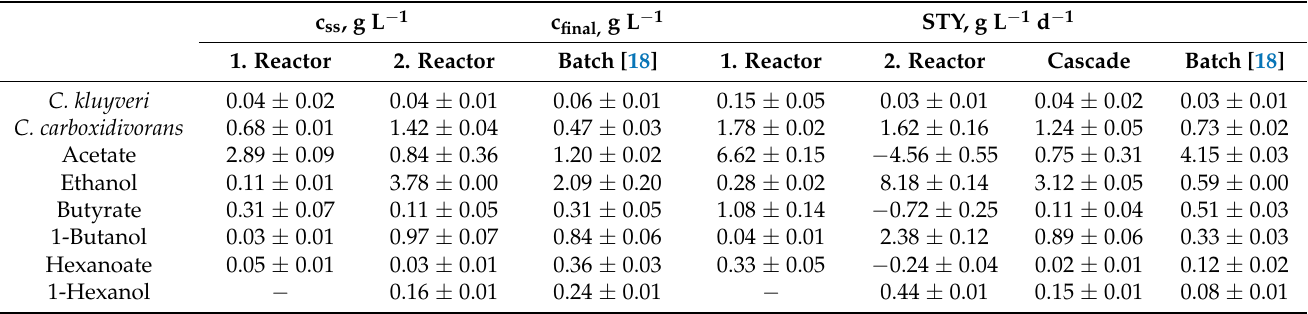
show de novo synthesis. Symbols show the mean and the minimum and maximum data of two phase is shaded in grey. Vertical lines indicate process time of five mean hydraulic residence times of the first reactor (dashed line) and of the bioreactor cascade (solid line). Table 1. Comparison of steady-state concentrations (c ss ) and space-time yields (STY) of the continu- ously operated autotrophic stirred-tank reactor cascade with C. carboxidivorans and C. kluyveri after 167 h (Figure 5) and the batch co-culture of C. carboxidivorans and C. kluyveri [18]. Cascade: dilution rate of 0.09 h − 1 in the first reactor and 0.06 h − 1 in the second reactor (T = 37 ◦ C, 200 mbar CO 2 ). First reactor: pH 6.0, p CO,in = 100 mbar, F gas = 0.042 vvm, 0.05 mM S 2 − L − 1 h − 1 ; second reactor: pH 5.0, p CO,in = 800 mbar, F gas = 0.083 vvm. Batch: p CO,in = 800 mbar, F gas = 0.083 vvm, pH 6.0, T = 37 ◦ C. Carbon balances were closed with 99% carbon